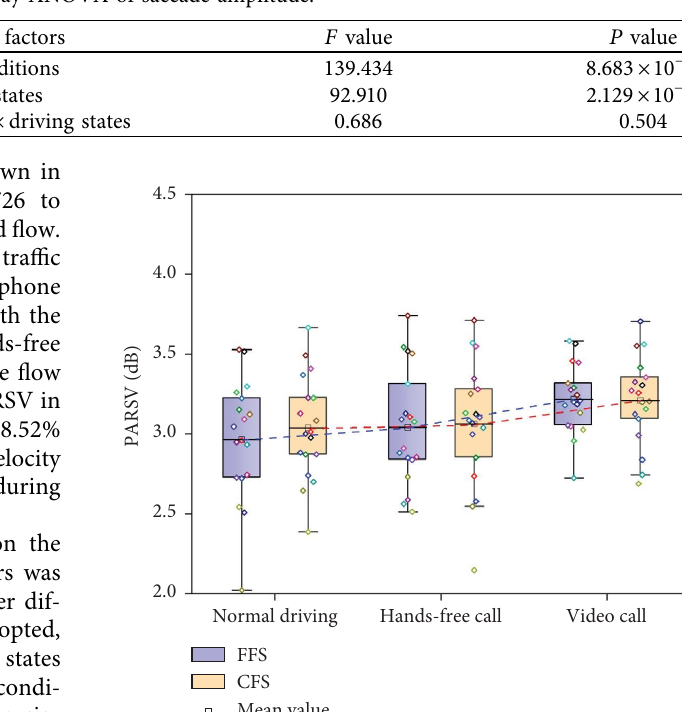
Table 6: Two-way ANOVA of saccade amplitude.